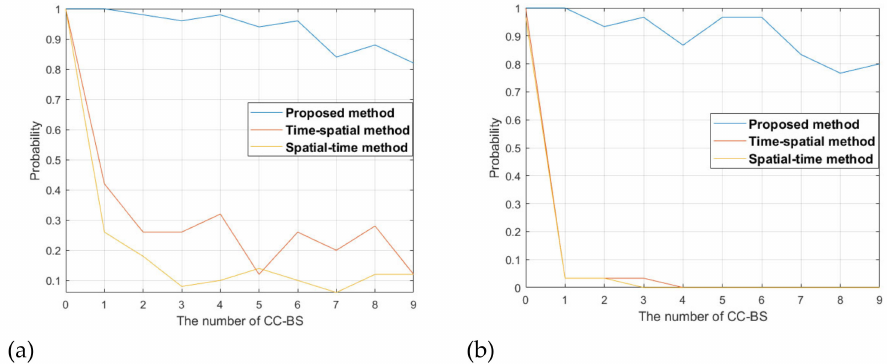
Figure 16. Comparison of interference suppression performance under different number of CCBSs, ( a ) interference from the sidelobe, ( b ) interference from the main